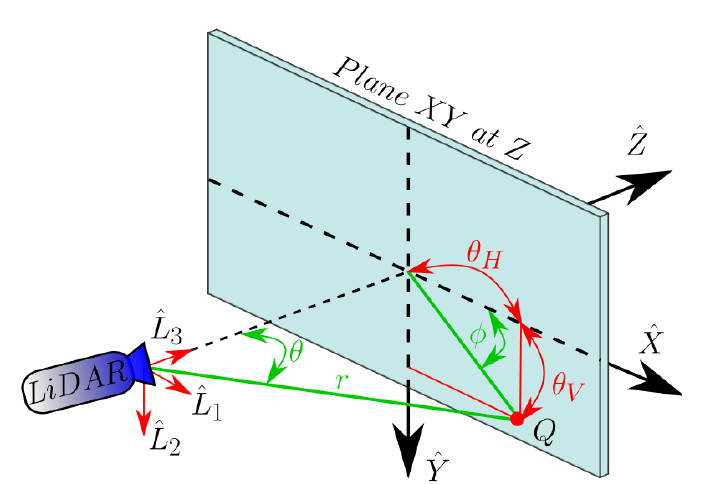
Figure 2. Scheme of the LiDAR Field-of-View (FOV) and an observed point Q relating ( red ) the LiDAR reference system and its scanning angles ( green ) in spherical